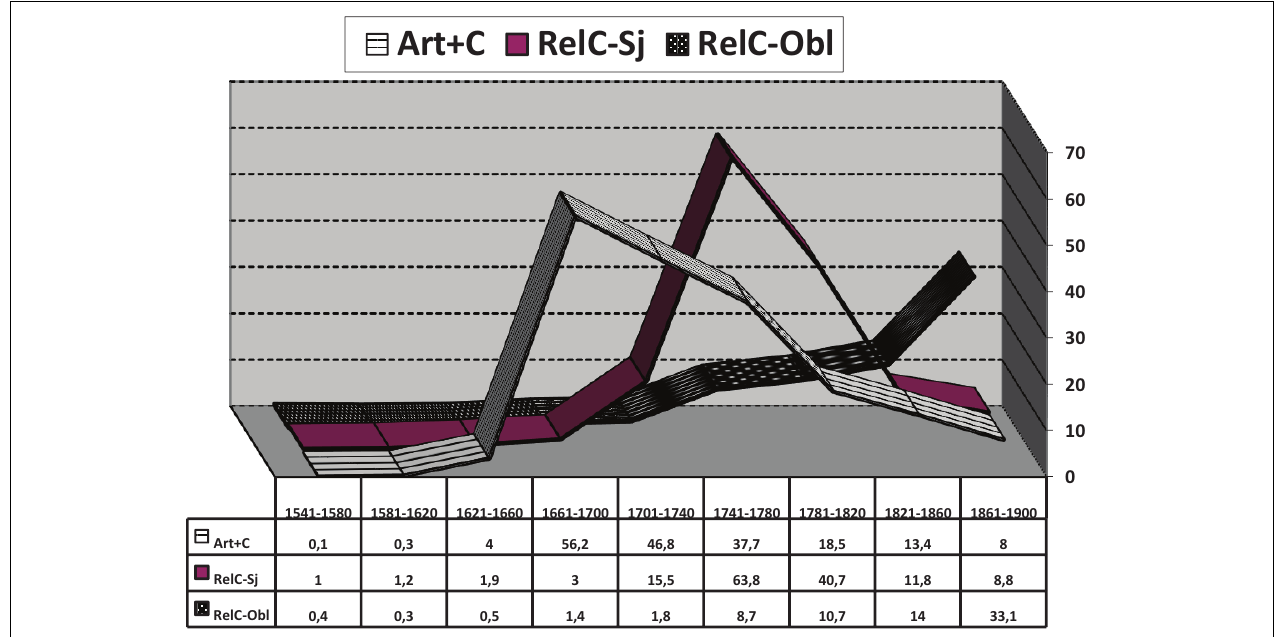
FIGURE 9 | Weighted frequency curves of ART + C (striped band), non-oblique (subject/object) compound relative pronouns (solid band), and oblique relative pronouns (band with light dots on dark background). Data from CORDE.